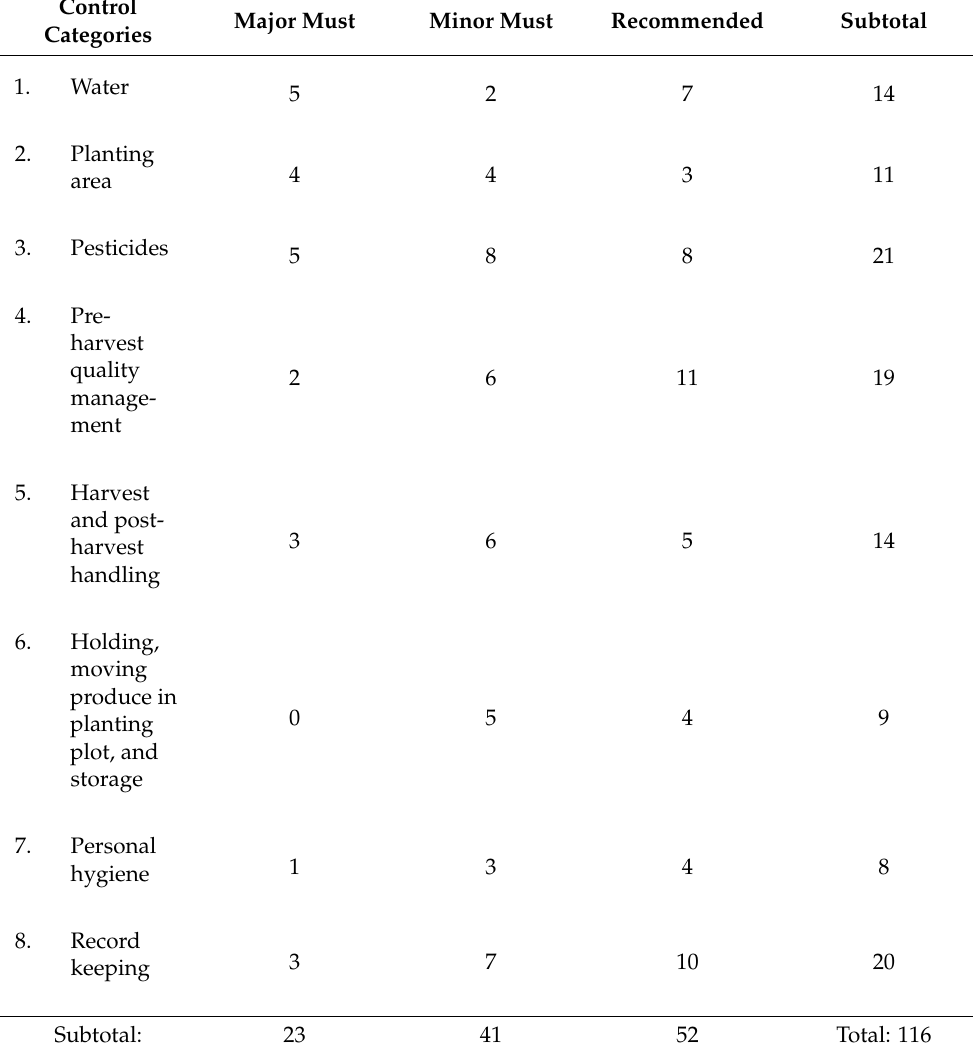
Table A2. Control points in the Q-GAP code of